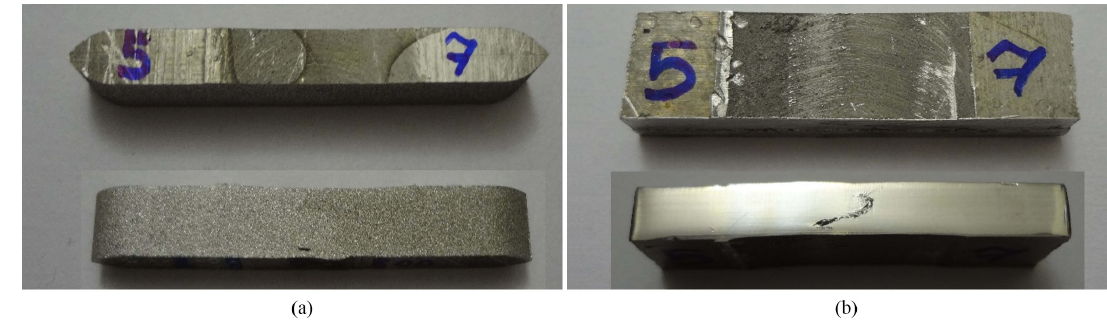
Figure 3. specimens’ shape used for (a) metallography and (b) corrosion.